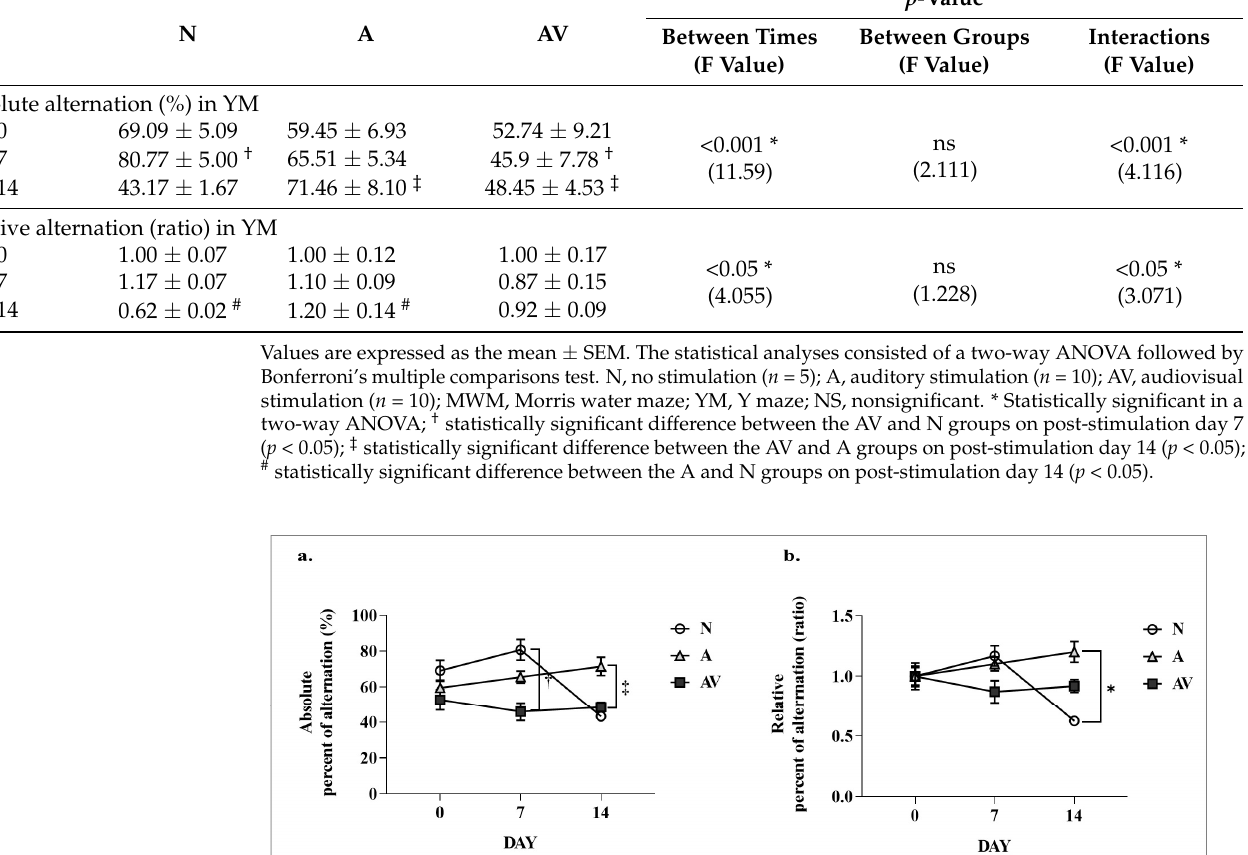
Table 1. Results of the Y maze test in ApoE4-KI mice after auditory and audiovisual stimulation. N